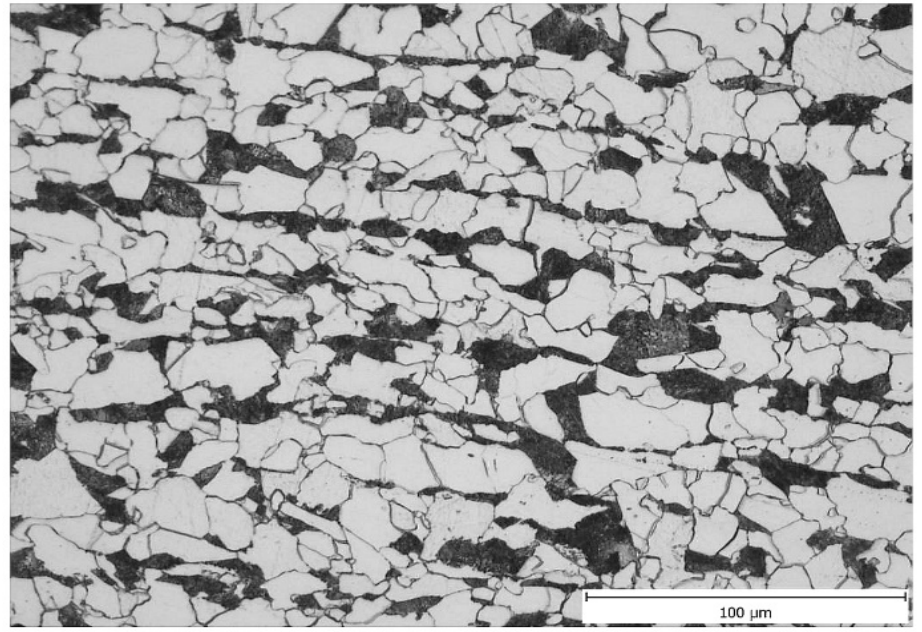
Figure 14. Ferritic–perlitic linear microstructure in the centre (sample V4).